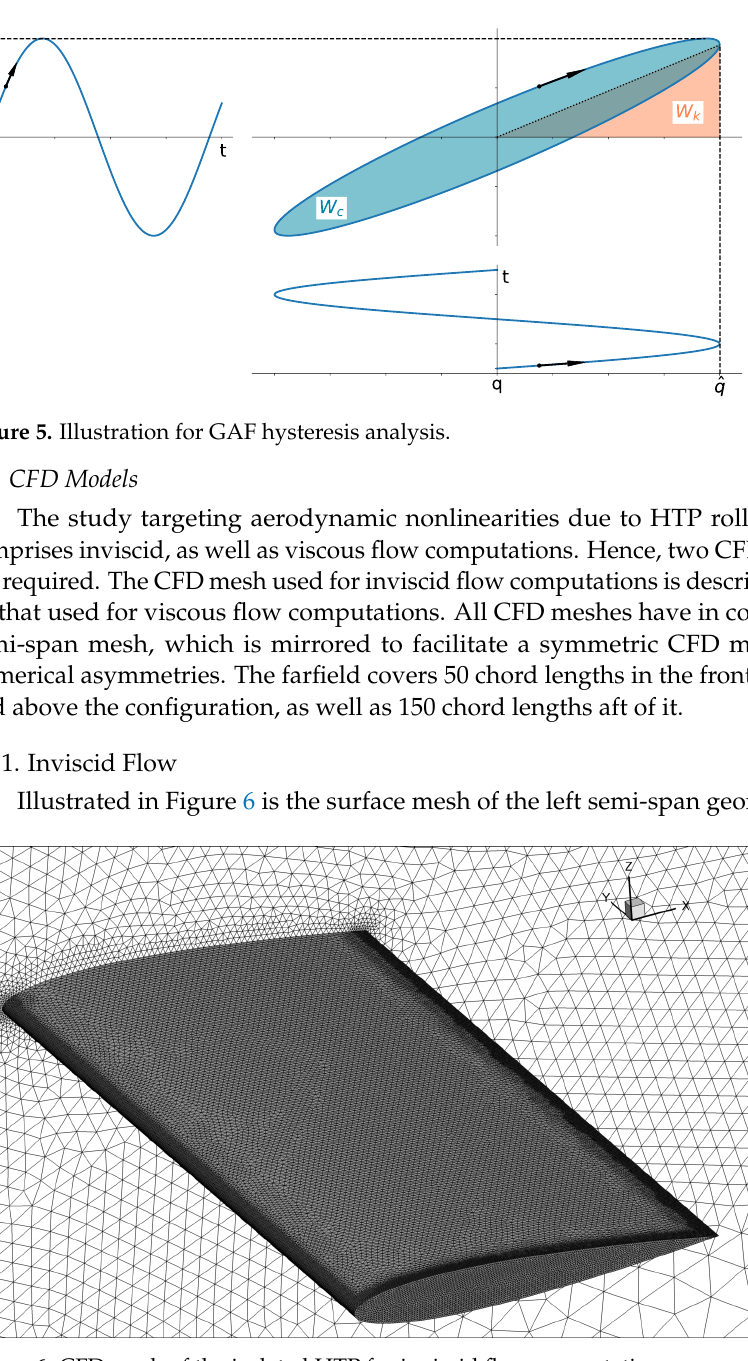
Figure 6. CFD mesh of the isolated HTP for inviscid flow